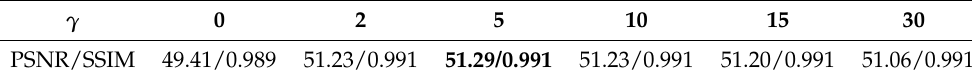
Table 3. Quantitative denoising results of different γ on SIDD validation datasets. γ 0